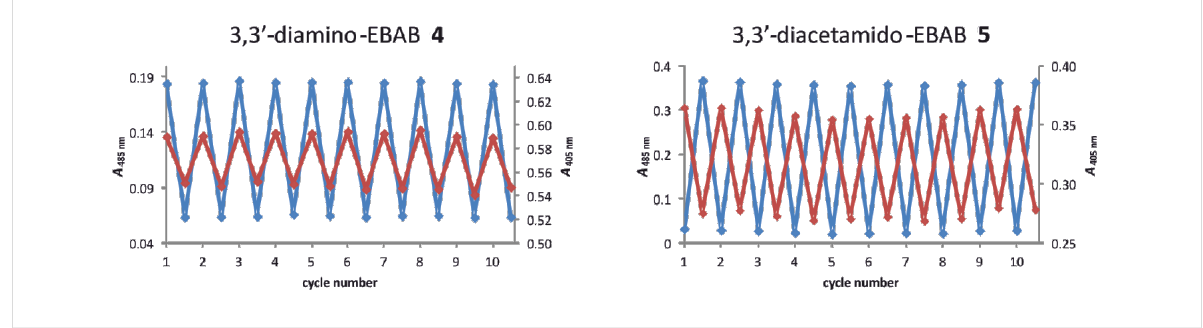
Figure 4: Absorbances of solutions of 4 and 5 in acetonitrile at 405 nm (red) and 485 nm (blue) in the corresponding photostationary states upon alternating irradiation at 405 and 530 nm.